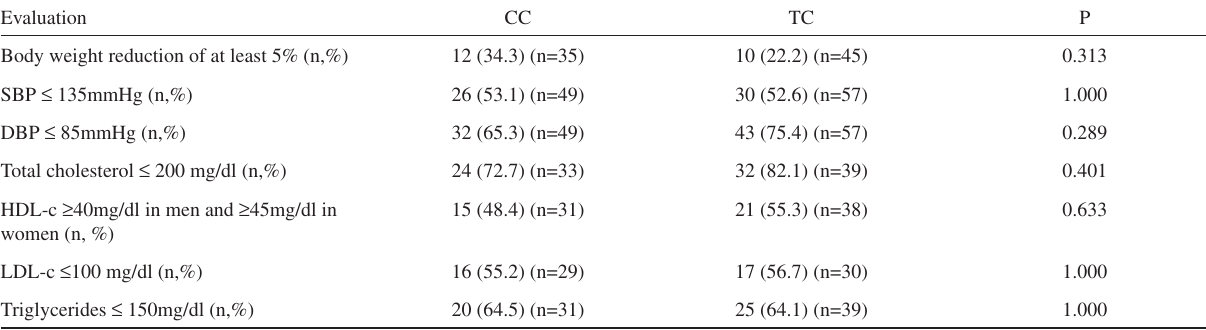
Table 3 - Clinical and laboratory characteristics of CC and TC patients at 60-180 days after AMI